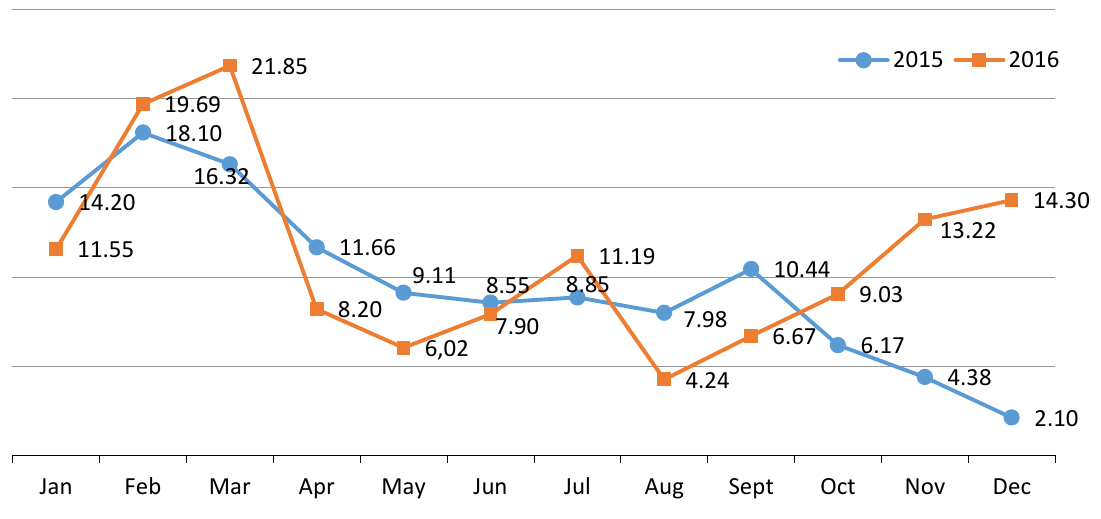
Figure 1. Procurement procedures announced in the period 2015–2016,